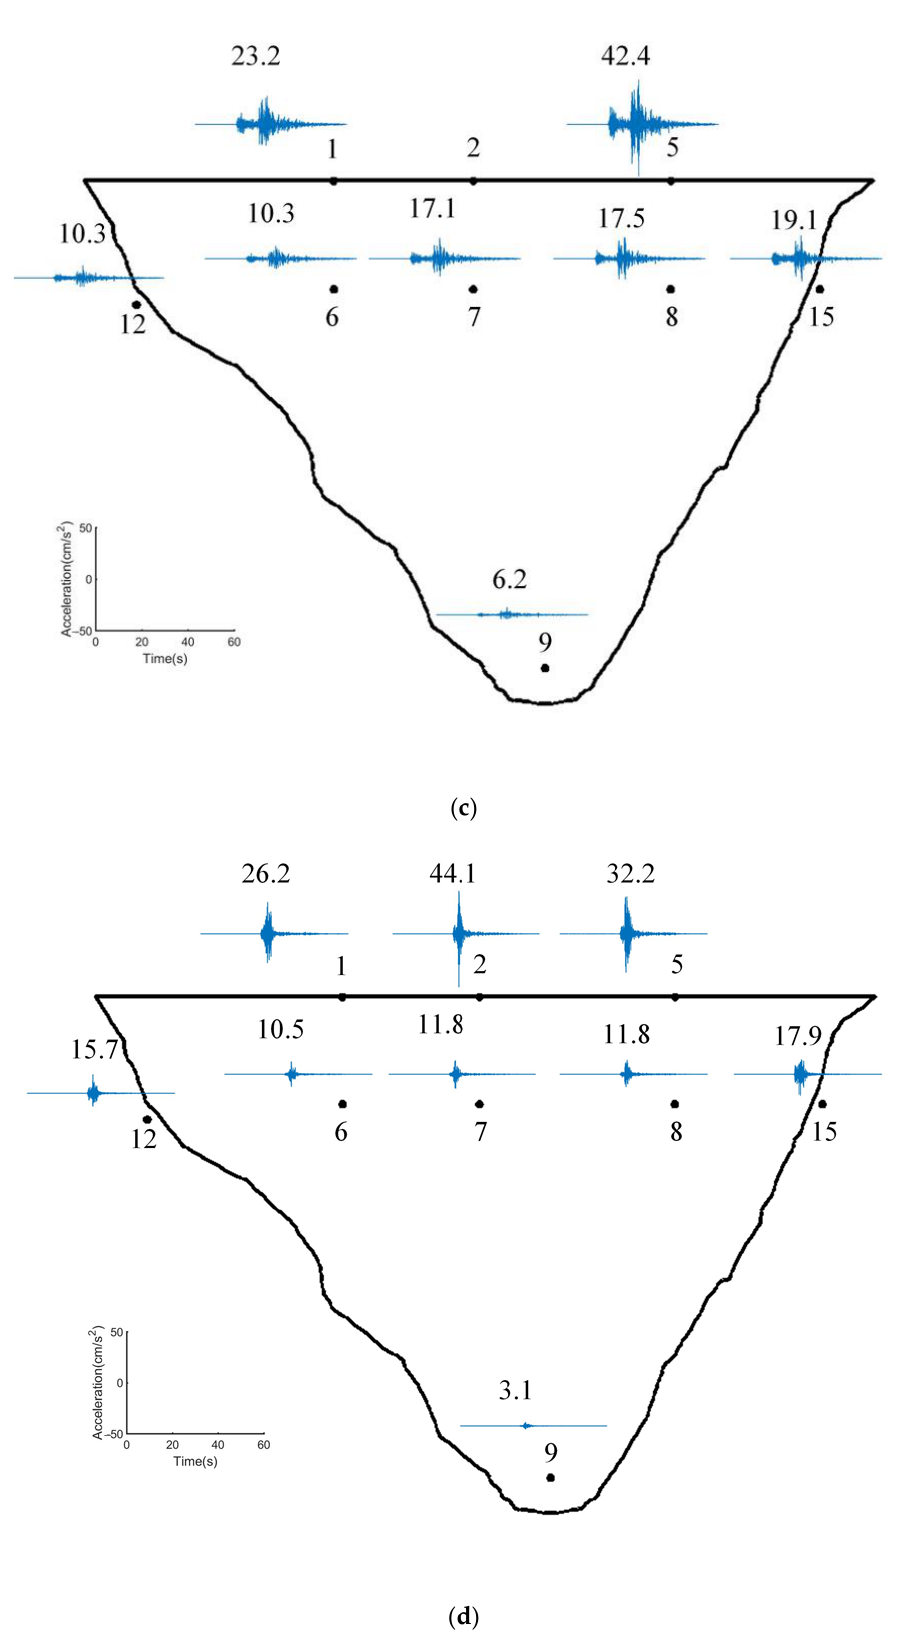
Figure 4. Earthquake responses of observation channels 1, 2, 5, 6, 7, 8, 9, 12, and 15 in the radial direction: ( a ) 1994 Northridge; ( b ) 2001 San Fernando; ( c ) 2008 Chino Hills; ( d ) 2011 Newhall.